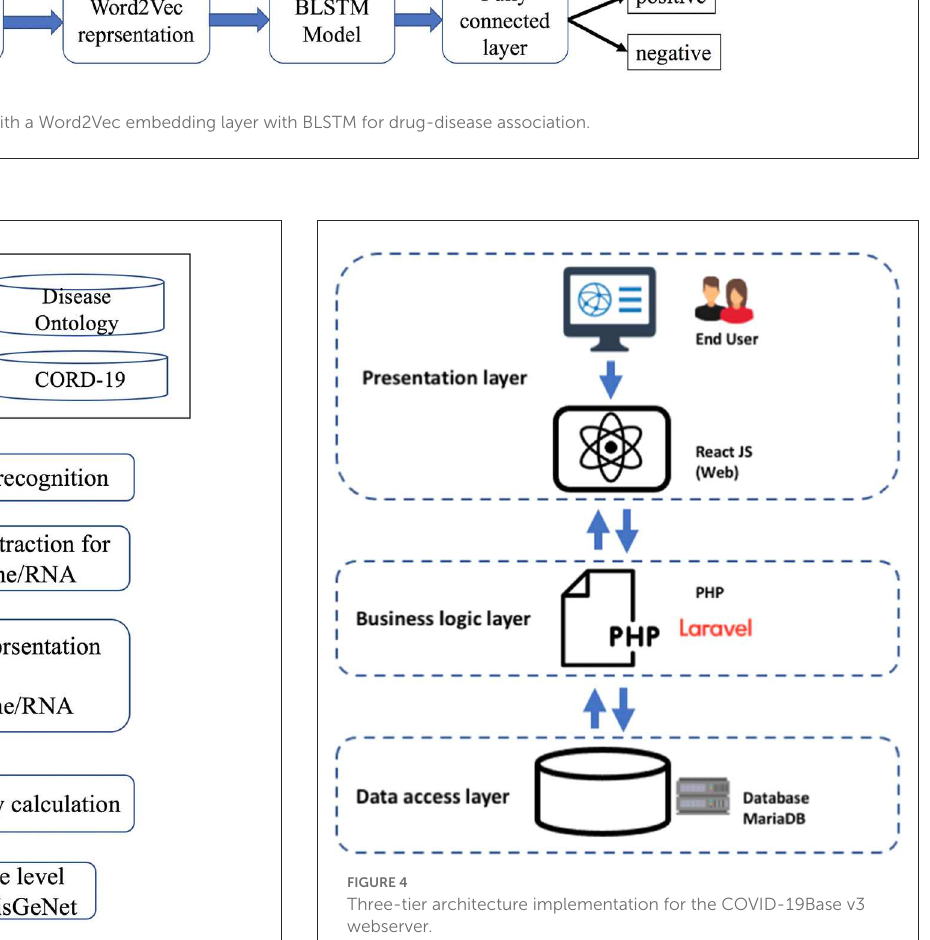
FIGURE3 Computational workflow for finding associations between disease and genes and RNAs.